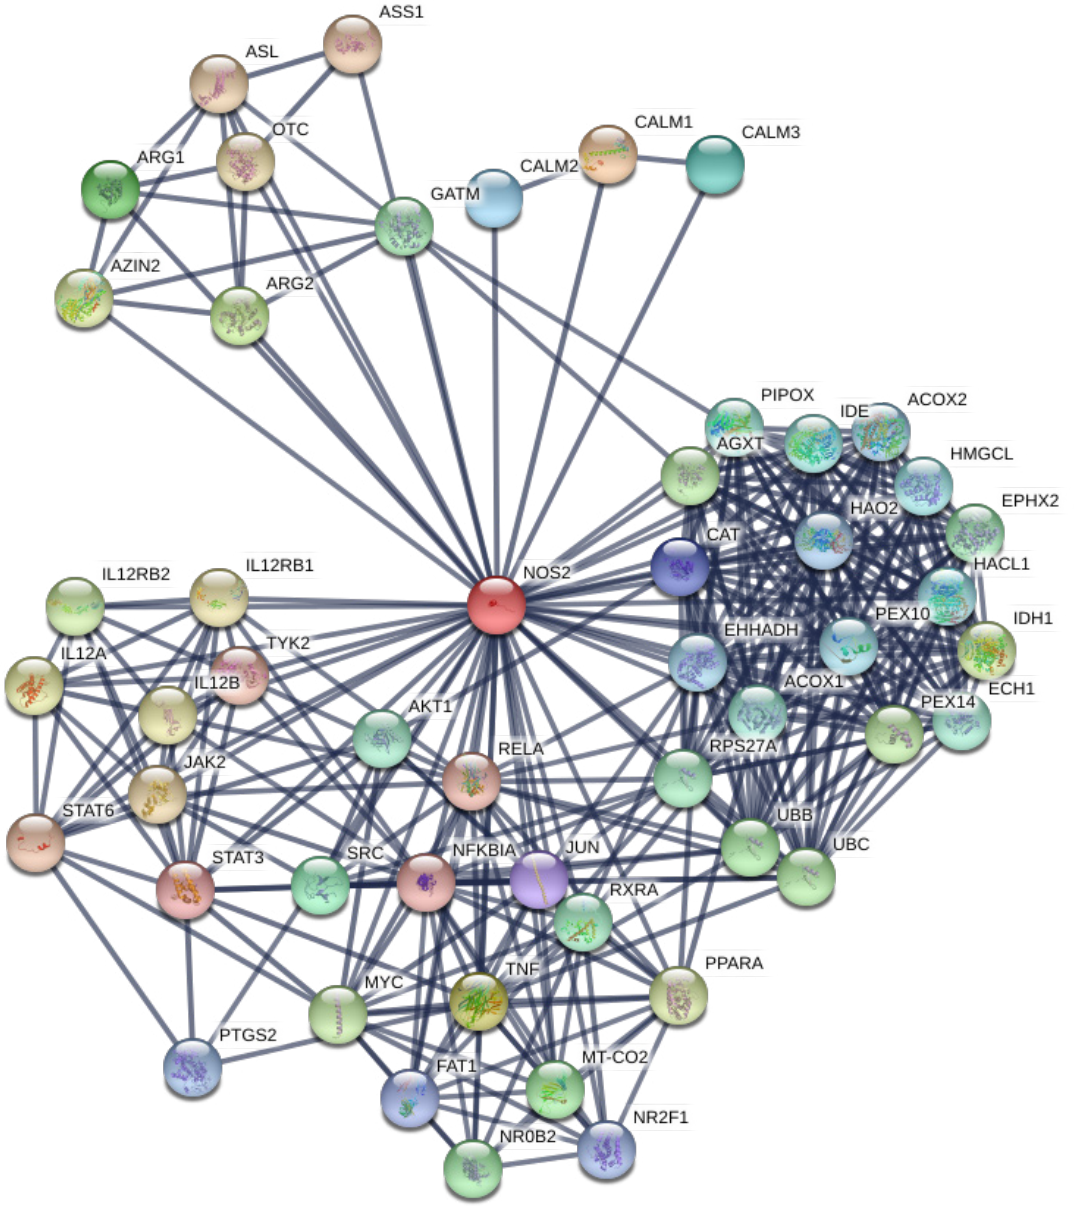
Figure 6: The PPI network of iNOS/NOS2 and relevant